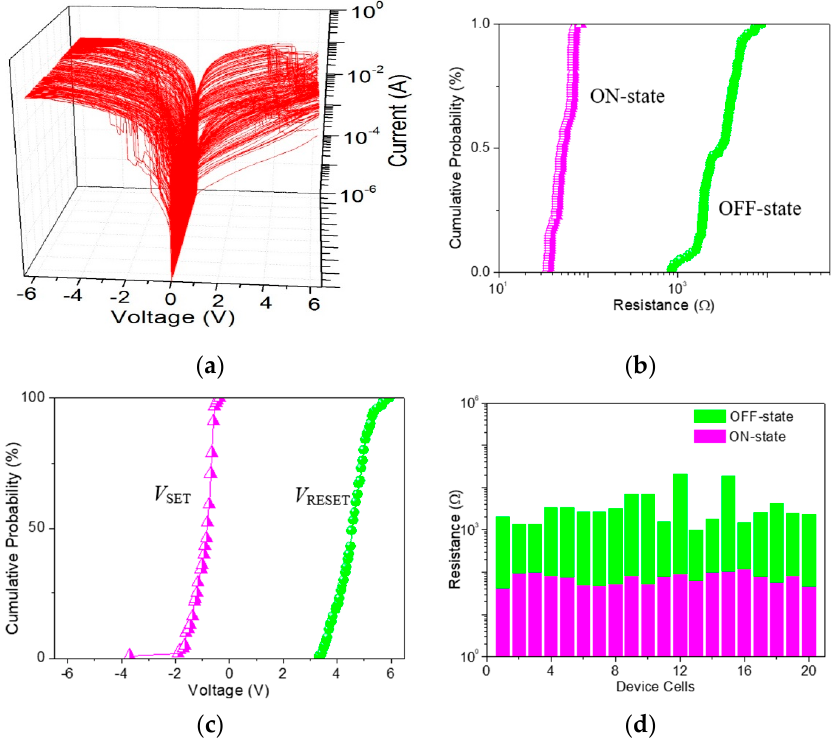
Figure 8. ( a ) 100 tristable sweeping cycles for ITO/GO:0.5 wt%GQDs/Ni; ( b ) Cumulative probability of the resistance in OFF, ON1 and ON2 states ( R OFF , R ON1 and R ON2 ), and ( c ) histograms of the SET1, SET2 and RESET voltage ( V SET1 , V SET2 and V RESET ) with respect to cycle-to-cycle operation in ITO/GO:0.5 wt%GQDs/Ni; ( d ) Device uniformity for 20 ITO/GO:0.5 wt%GQDs/Ni cells concerning R OFF , R ON1 and R ON2 .